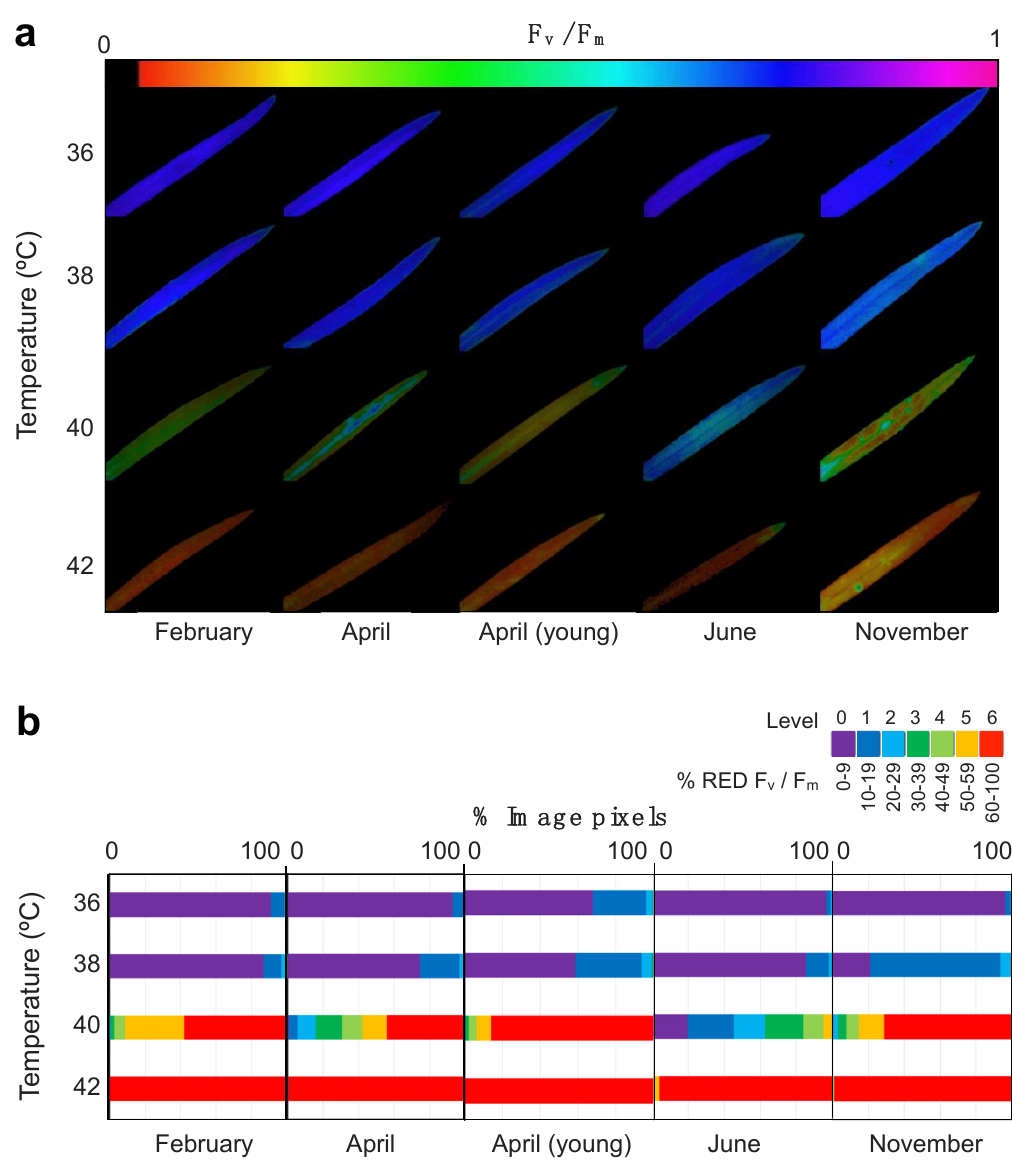
Figure 4. Effect of high temperature treatment on E. scoparium leaves as obtained from chlorophyll fluorescence imaging analysis. ( a ) Representative images of chlorophyll fluorescence showing F v /F m values of whole leaves after selected temperature treatments. ( b ) Summary of the quantitative analyses of F v /F m images. The % of reduction in the F v /F m was classified in seven stress levels as shown in the legend (violet: Low to non-reduction, red: Dramatic reduction). The length of the horizontal colour bars is proportional to the number of image pixels of each